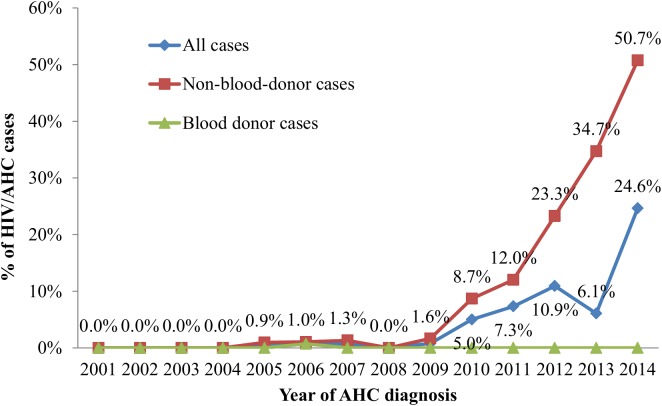
Proportion of HIV/AHC cases among AHC cases with documented HCV seroconversion, Taiwan, 2001–2014.